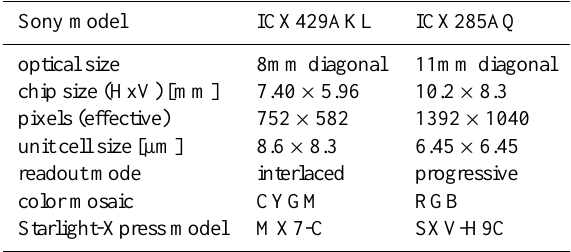
Table 3. Characteristics of two color mosaic